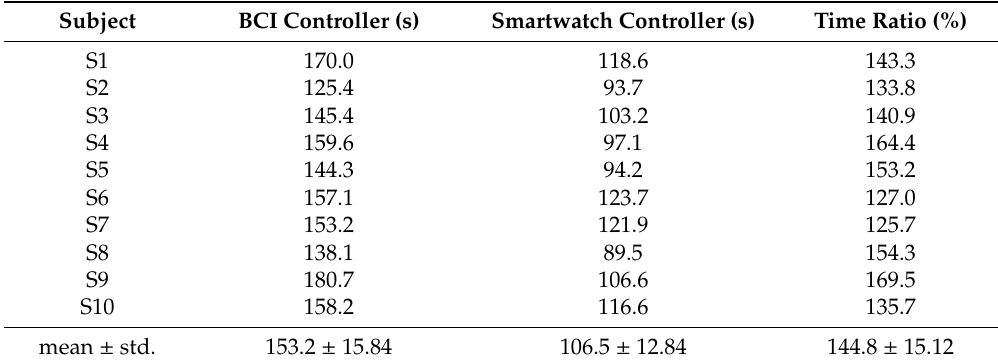
Table 2. Comparison of operating time between the development hybrid BCI controller and the smartwatch controller.